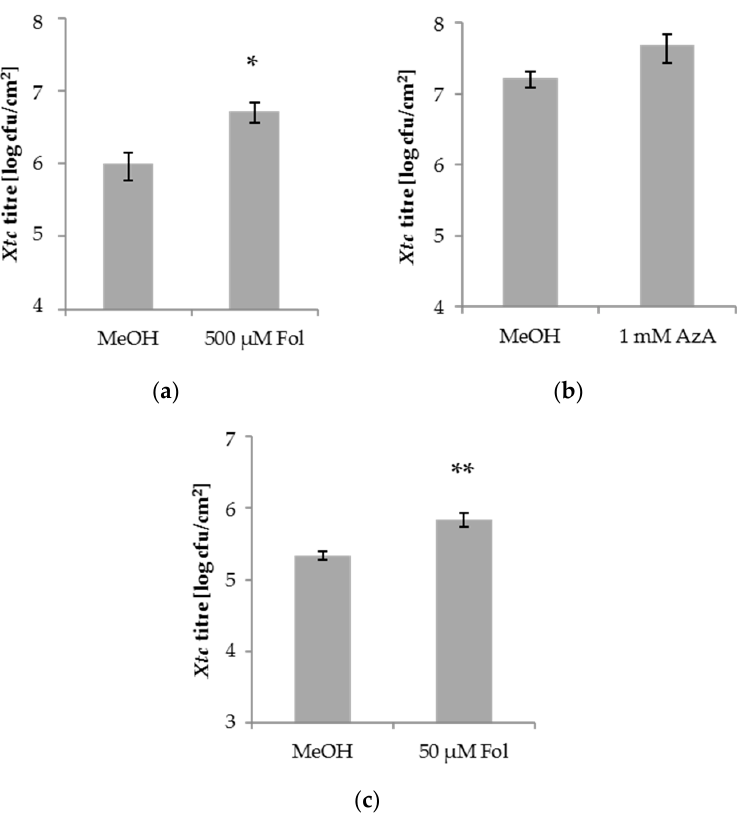
Figure 1. Xanthomonas translucens pv. cerealis ( Xtc ) titres in the systemic leaves of barley after local application of folic acid ( Fol) or azelaic acid (AzA). Barley cultivar Golden Promise (GP) plants were infiltrated in the first true leaf with 0.025% methanol (MeOH) as control, 500 µM Fol ( a ), 1 mM AzA ( b ), or 50 µM Fol ( c ) in 10 mM MgCl 2 as indicated below the panels. Five days later, the second true leaves of the plants were inoculated with Xtc by syringe infiltration. The resulting Xtc titres in leaf 2 at 4 dpi are shown. Bars represent the average of 18–36 replicates from 5 (( a ): 4× greenhouse, 1× growth chamber; ( b ): 3× greenhouse, 2× growth chamber) to 9 (( c ): 8× greenhouse, 1× growth chamber) biologically independent experiments ± standard error; replicates were as follows: ( a ) MeOH: 19 (4 + 4 + 3 + 4 + 4), Fol: 18 (4 + 4 + 3 + 4 + 3), ( b ) MeOH: 19 (4 + 3 + 3 + 4 + 5), AzA: 20 (4 + 4 + 4 + 4 + 4), ( c ) MeOH: 34 (4 + 3 + 4 + 4 + 3 + 4 + 4 + 4 + 4), Fol: 36 (4 + 4 + 4 + 4 + 4 + 4 + 4 + 4 + 4). Asterisks above bars